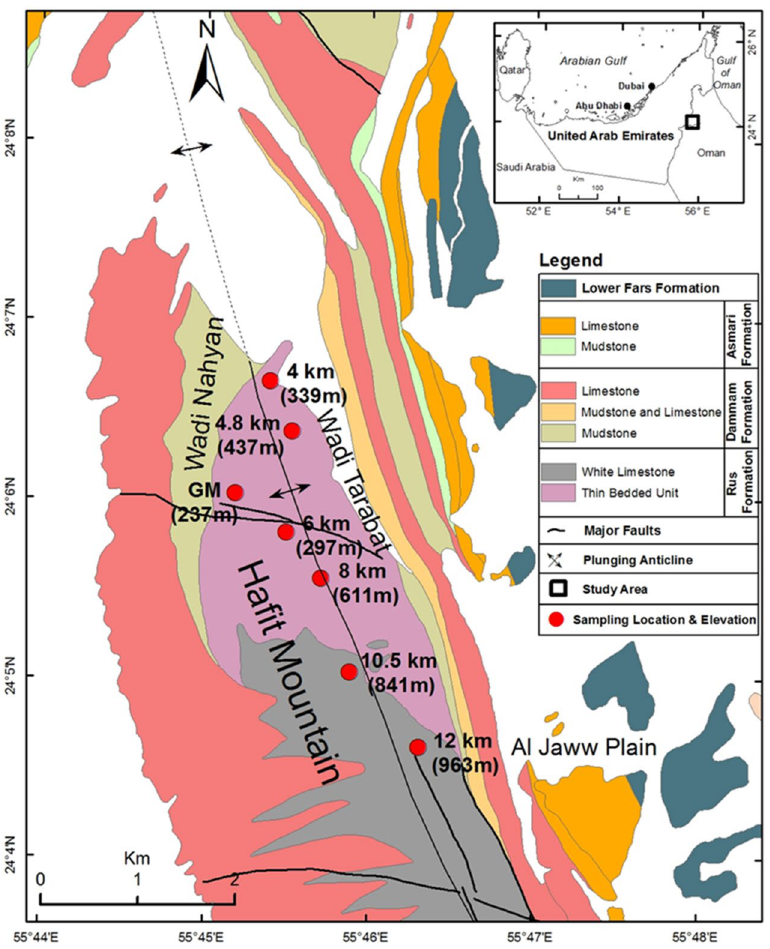
Figure 1. Location map of the sample sites with the geology of the Hafit Mountain (generated with ArcGIS 10.8 21